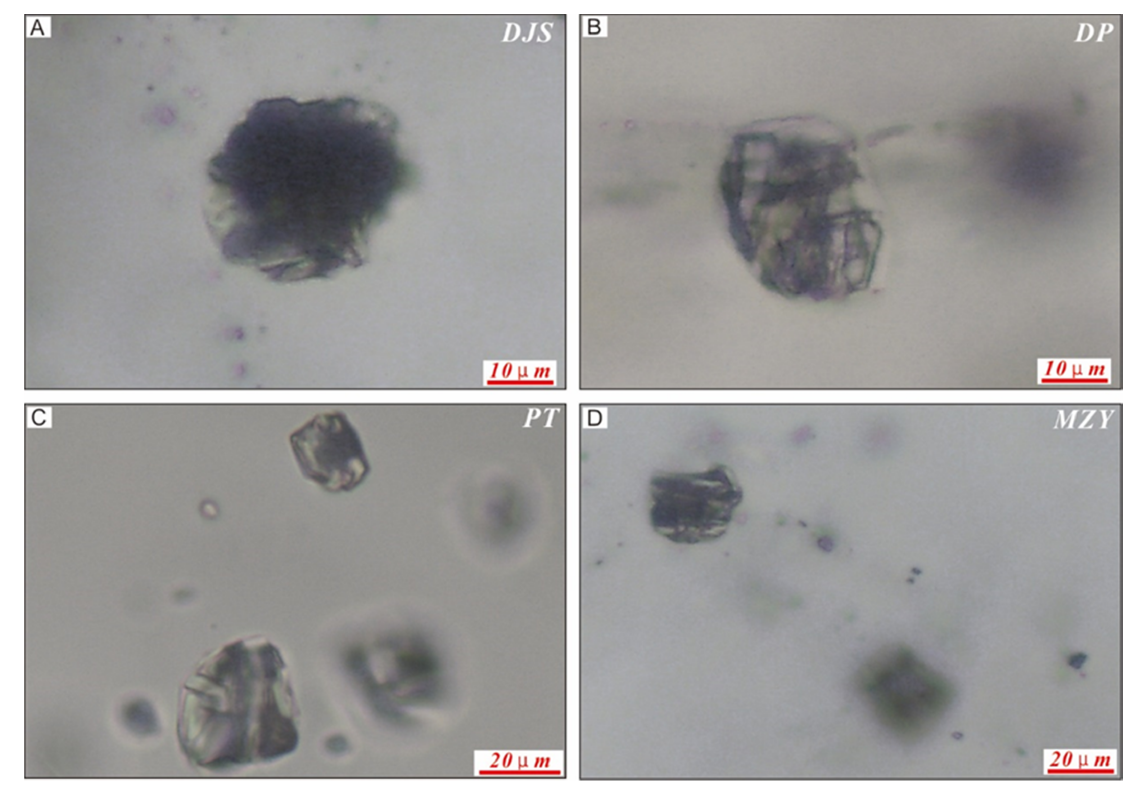
Figure 13. Melt inclusions trapped in quartz from granite. Typical melt inclusions from the Dajishan ( A ), Dangping ( B ), Piaotang ( C ) and Muziyuan ( D ) tungsten deposits in South China. Abbreviations: DJS—Dajishan; DP—Dangping; PT—Piaotang; MZY—Muziyuan.